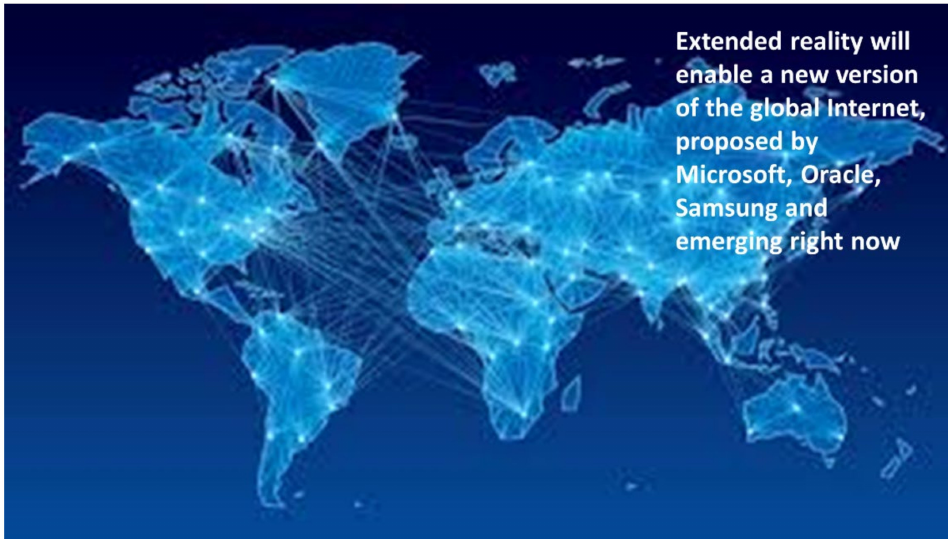
Figure 1. Major vendor reports foresee ER will shape a new form of Internet interface to customers and employees, emerging late